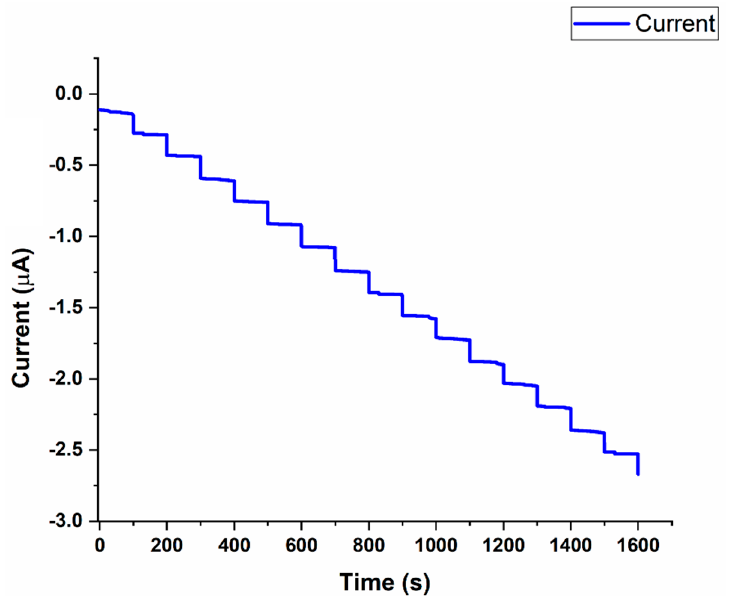
Figure 4. Amperometric current response at − 0.1 V (w.r.t the Ag/AgCl reference electrode) with successive addition of 100 µM glucose concentration (0 µM~1.6 mM in 0.01 M PBS solution). Inset: Experimental setup used to develop the calibration plot.